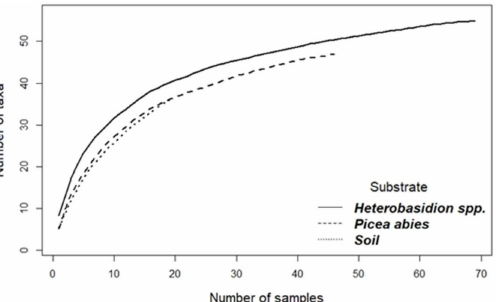
Figure 3. Accumulation curves showing the relationship between the cumulative number of inverte- brate taxa and the number of collected